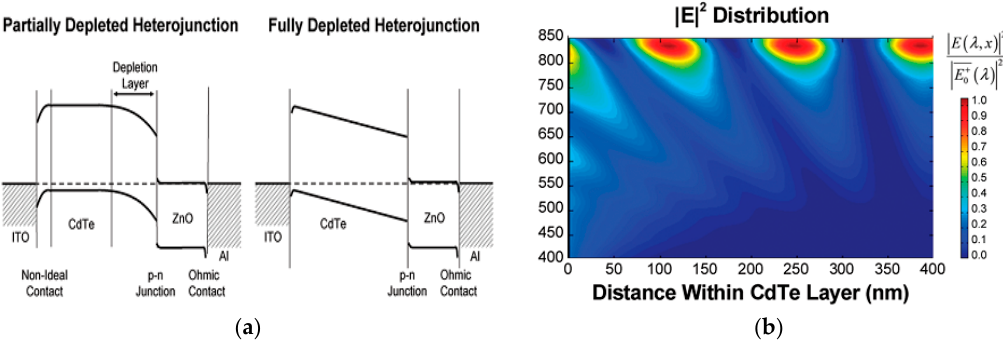
Figure 5. ( a ) Schematic representations of partially ‐ and fully ‐ depleted abrupt heterojunctions based on the device architecture explored in this work. ( b ) The spatial and wavelength ‐ dependent optical field density that has been normalized by the incoming field and the simulated exciton generation rate within the CdTe layer of an optimized device with 400 nm CdTe and 60 nm ZnO layers. The exciton generation rate is simulated with the standard AM 1.5 100 mW/cm 2 irradiance as the incoming light source. Reproduced with permission from [8]. Copyright 2011, American Chemical Society.